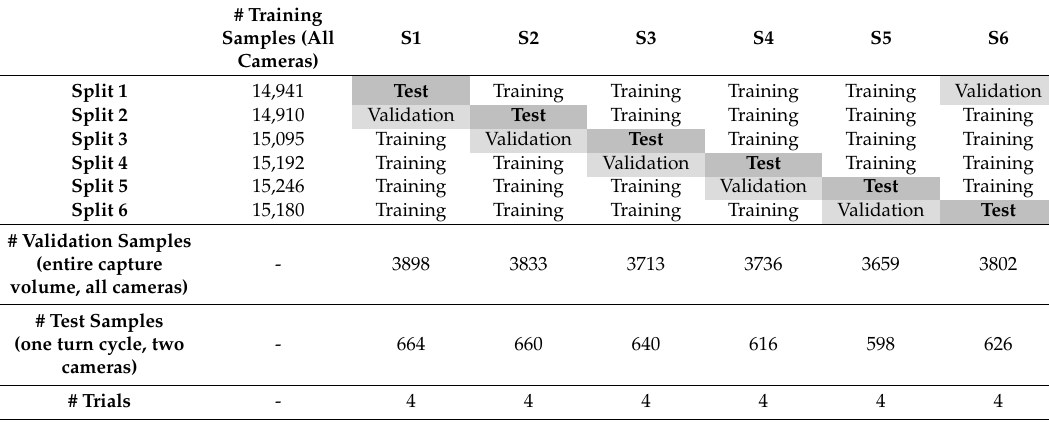
Table 1. Design of the algorithm training, validation, and testing; we followed a six-fold cross validation scheme to report results for all subjects while training on independent parts of the